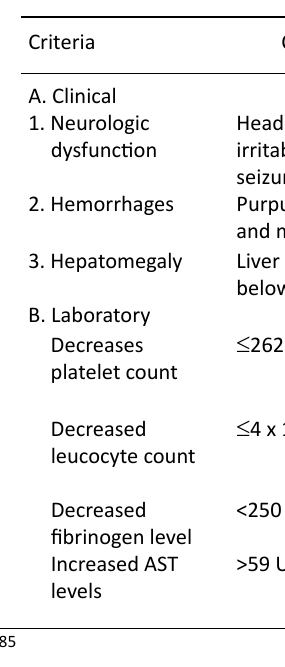
Table 3. Diagnostic criteria of MAS as formulated in 2004 18 Criterias 1.